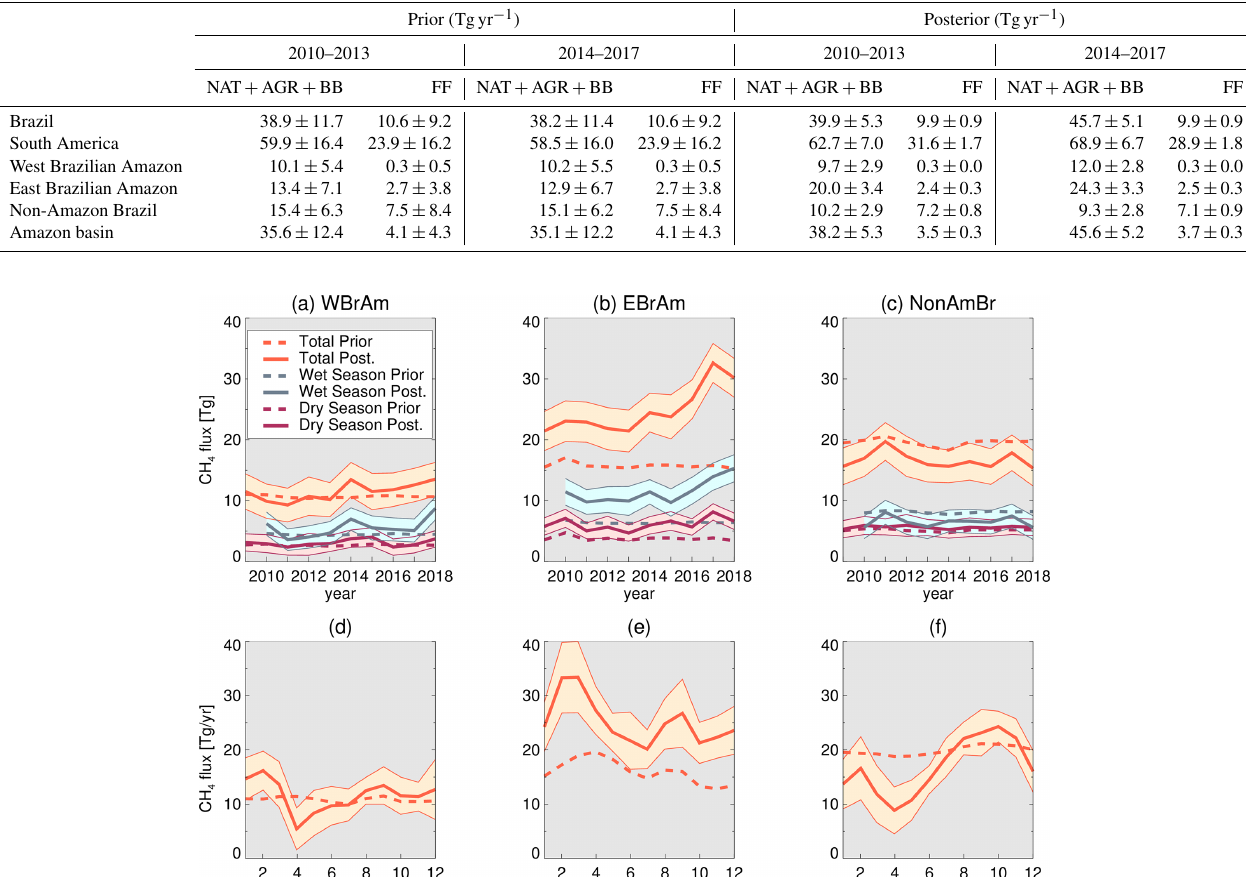
Figure 5. (a–c) Total annual (red lines) prior and posterior emissions of CH 4 (Tgyr − 1 ) in three Brazilian subregions: the western Brazilian Amazon (WBrAm), the eastern Brazilian Amazon (EBrAm) and non-Amazon Brazil (NonAmBr). Prior and posterior emissions during the wet season (December–March, grey lines) and the dry season (August–October, maroon lines) are also shown. Shading represents the posterior uncertainties for each region derived in the inversion. (d–f) Monthly mean prior and posterior emissions for the period 2009–2018 (Tgyr − 1 ) for the three subregions. Shading shows the standard deviation of the monthly